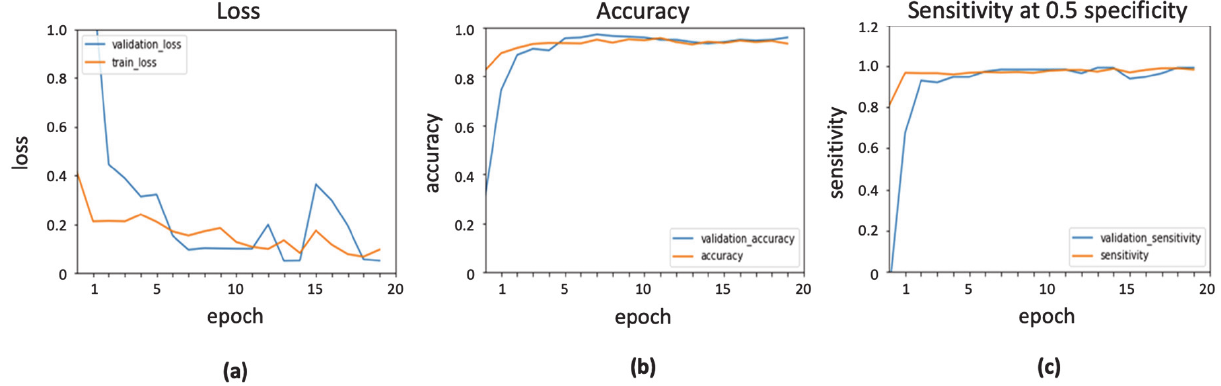
Figure 6. Output obtained using ADADelta optimizer: ( a ) loss function; ( b ) accuracy; ( c ) sensitiv- ity.